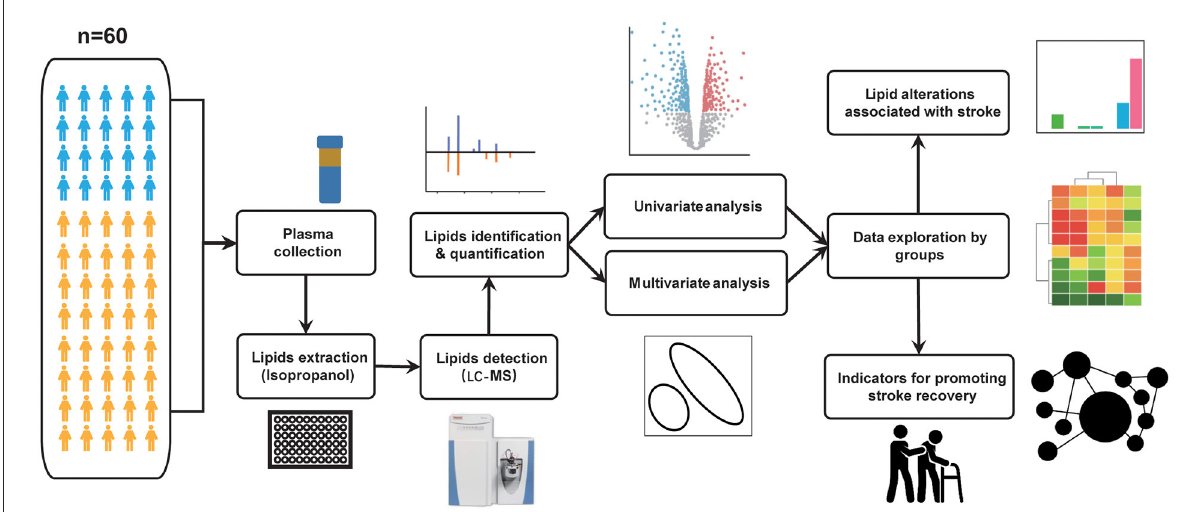
FIGURE1 Flowchart illustrating the comprehensive framework of this study. A total of 60 subjects were recruited for this study, including 20 healthy and 40 acute stroke individuals. Plasma samples were collected from all study participants and pre-treated as described in the methods section. Using the untargeted profiling strategies by LC-MS platform, lipid features were identified and quantified from plasma samples. Multivariate and univariate analyses are used for data quality assessment and for exploring altered lipid molecular species among groups. Following that, we explored the data on two levels. (1) Based on the three groups mentioned above, we used the T test or Wilcoxon rank-sum test to identify differential lipid species in each group. (2) Based on the Barthel Index, we re-divided the patients into good and poor recovery groups. Potential indicators were detected based on the Wilcoxon rank-sum test. In addition, we built a network to investigate the correlations or interactions between pairs of lipid molecules.